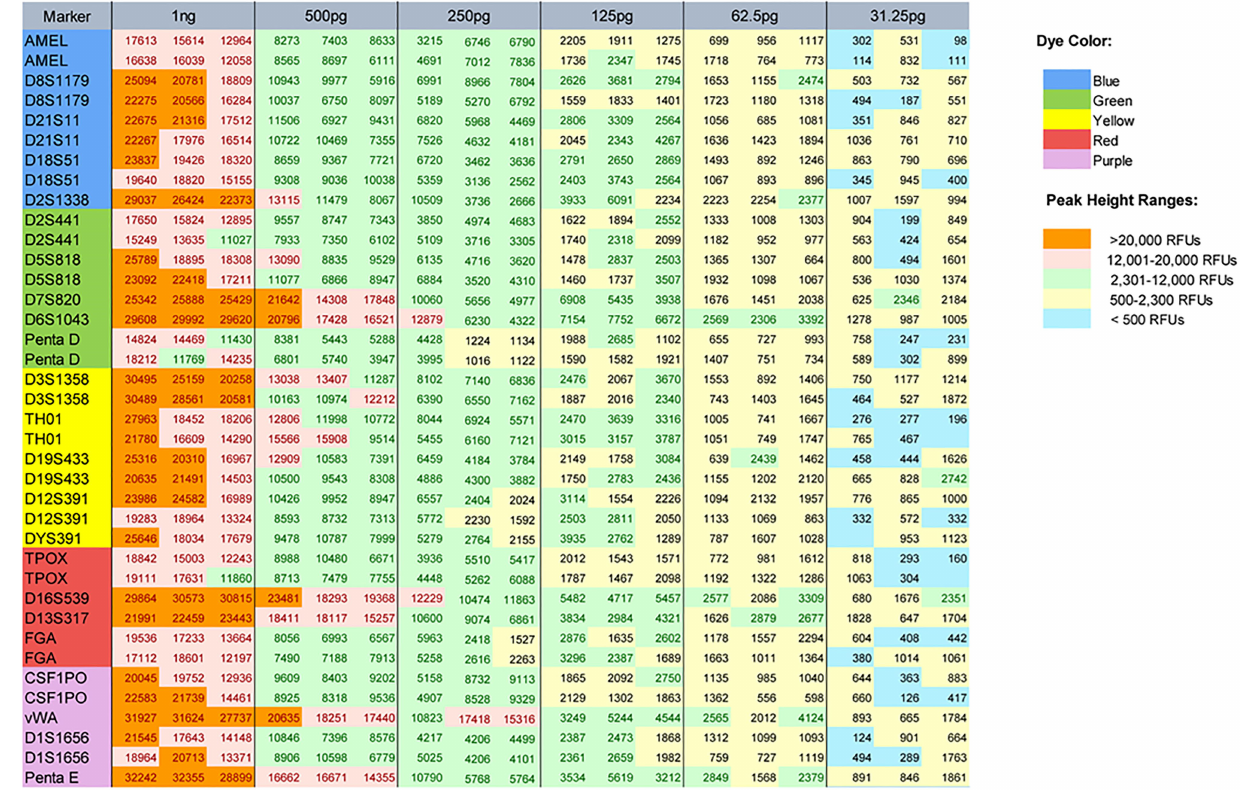
TABLE 2 | Stochastic effects observed in sensitivity study with varying inputs of 9948 for 2 + 27 cycles in triple. 9948 (pg) Loci number of Average PHR Lowest PHR Lowest Het. PHR < 0.7